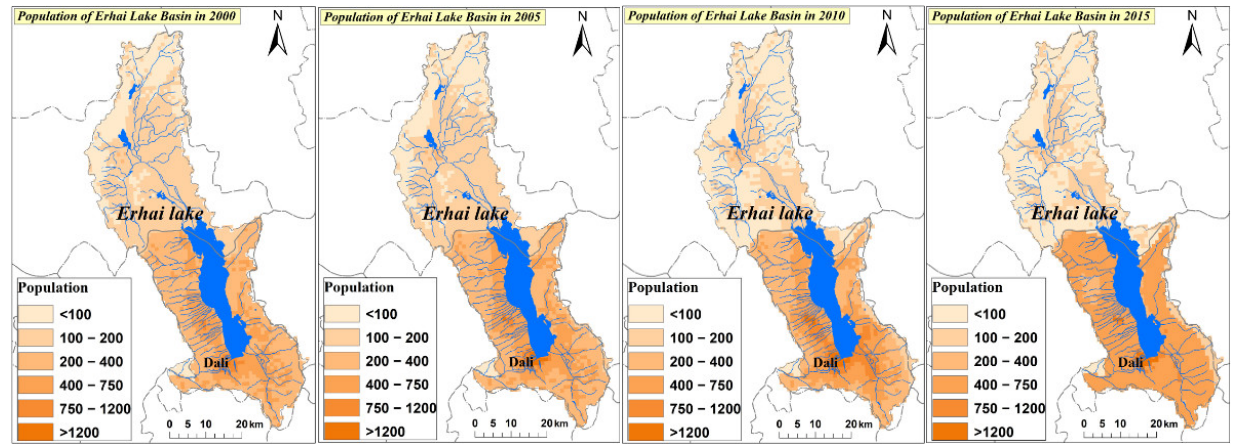
Figure 9. Spatial distribution of the population in Erhai Lake from 2000 to 2015 (unit: 10 4 ).